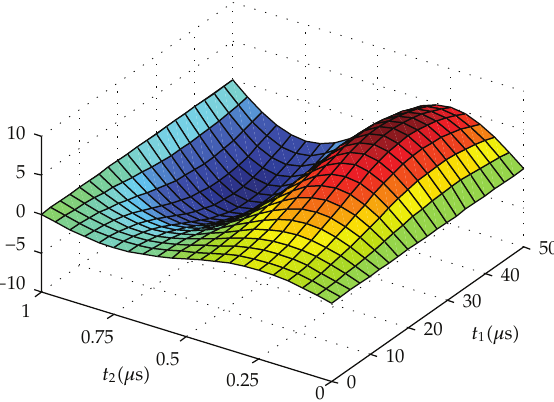
Figure 4: Bivariate representation of the amplitude-modulated RF